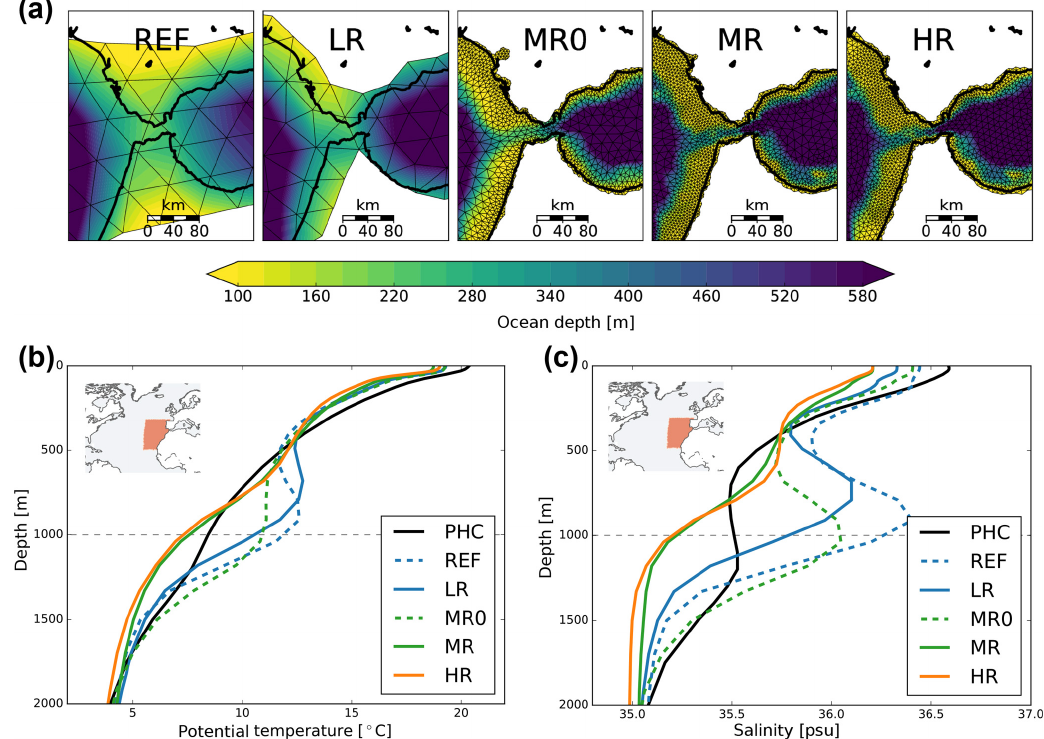
Figure 8. (a) Spatial discretization of the Strait of Gibraltar and the Gulf of Cádiz in the five different model grids. The thick black line shows the true coastline as implemented in the Basemap plotting toolbox, using data from GSHHS (http://www.soest.hawaii.edu/pwessel/gshhs/ index.html, last access: 17 May 2019). Triangular elements are shown with thin black lines; colors depict the local ocean depth in meters. (b, c) Vertical profiles of regionally averaged potential temperature and salinity in the vicinity of the Strait of Gibraltar (20–40 ◦ N, 5–30 ◦ W; red box in the insets). The horizontal dashed line highlights the depth of